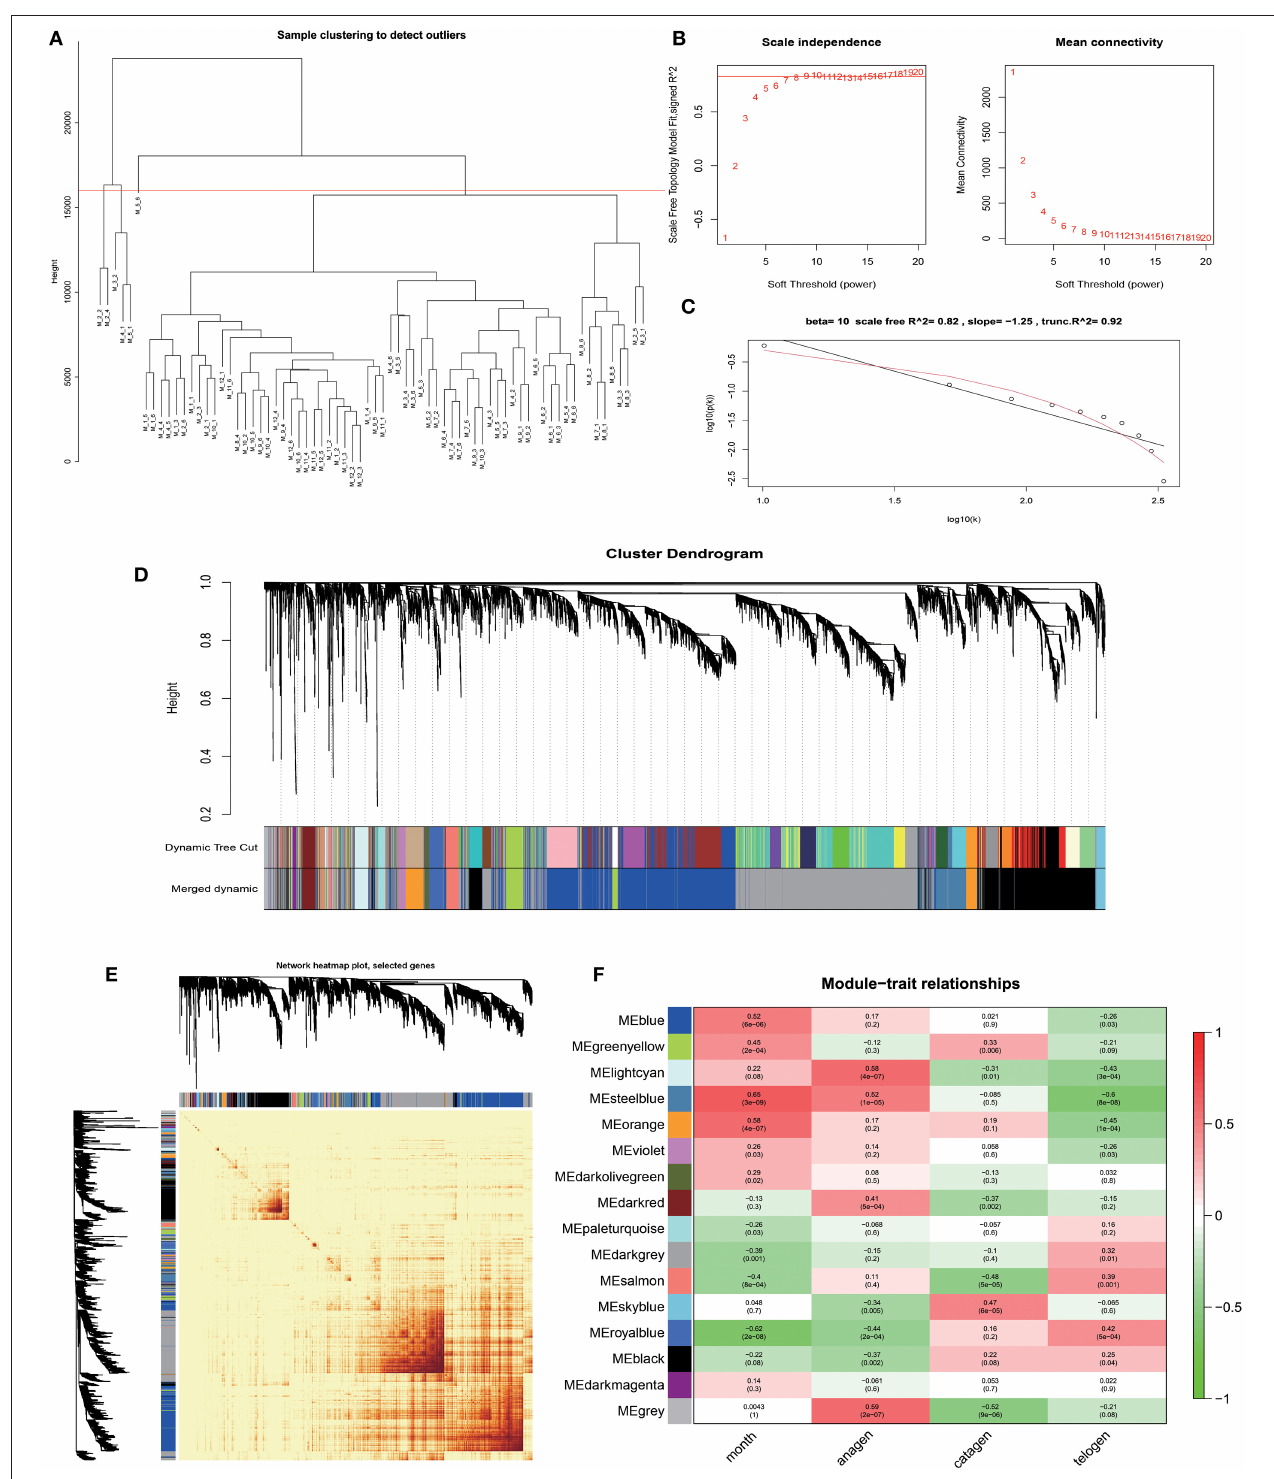
FIGURE 2 | Identification of co-expression modules by WGCNA. (A) Hierarchical clustering information of samples, red line = 16,000. (B) The determination of soft thresholding power. (C) When β = 10, the scale-free network fitting. (D) The gene clustering dendrogram was obtained according to hierarchic clustering of adjacency based dissimilarity. (E) Network heatmap of module-genes, Each tree represents a module, each branch represents a gene, and the darker the color of each dot, the stronger the connectivity between the two genes corresponding to the row and column. (F) Module–trait relationships, Abscissa is the trait, the ordinate is the module, the number of each grid represents the correlation between the module and the trait, and the number in parentheses represents p -value.